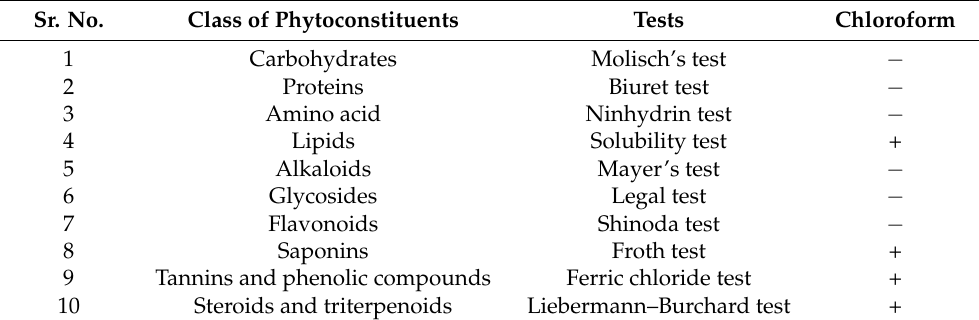
Table 2. Results of phytochemical screening of chloroform extract of E. microphylla . Sr. No.